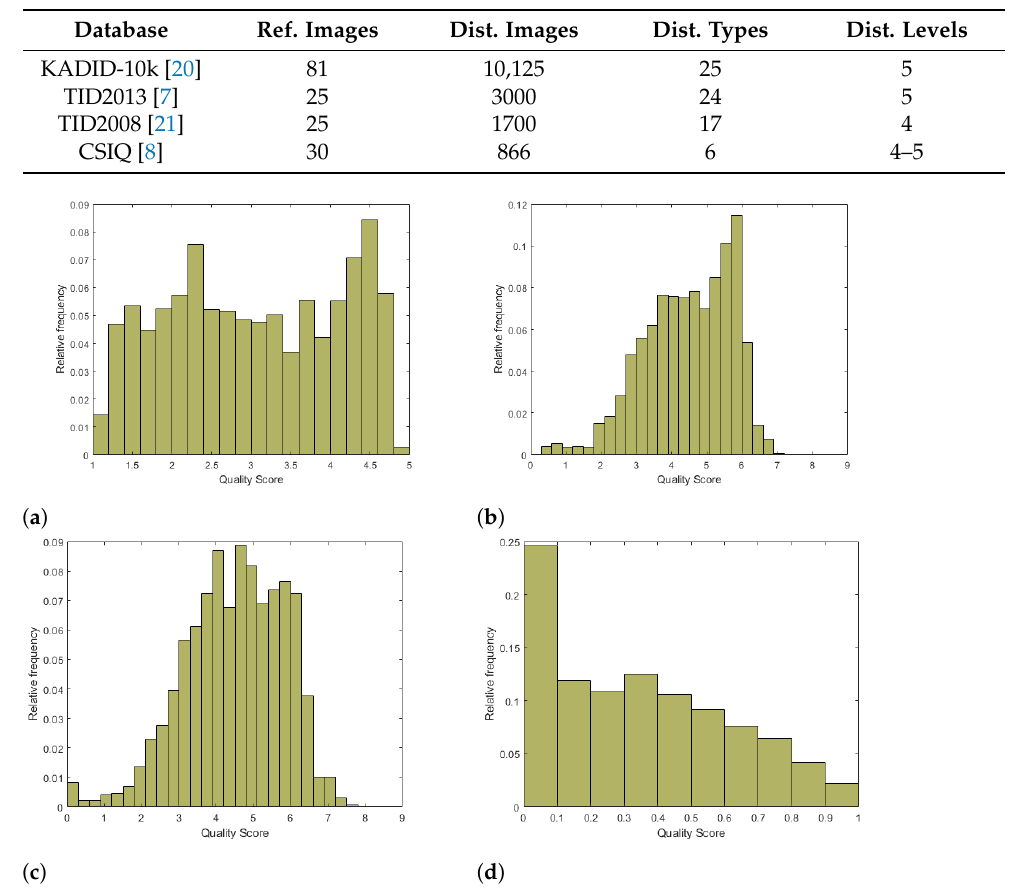
Table 1. Summary of benchmark databases used in this study.